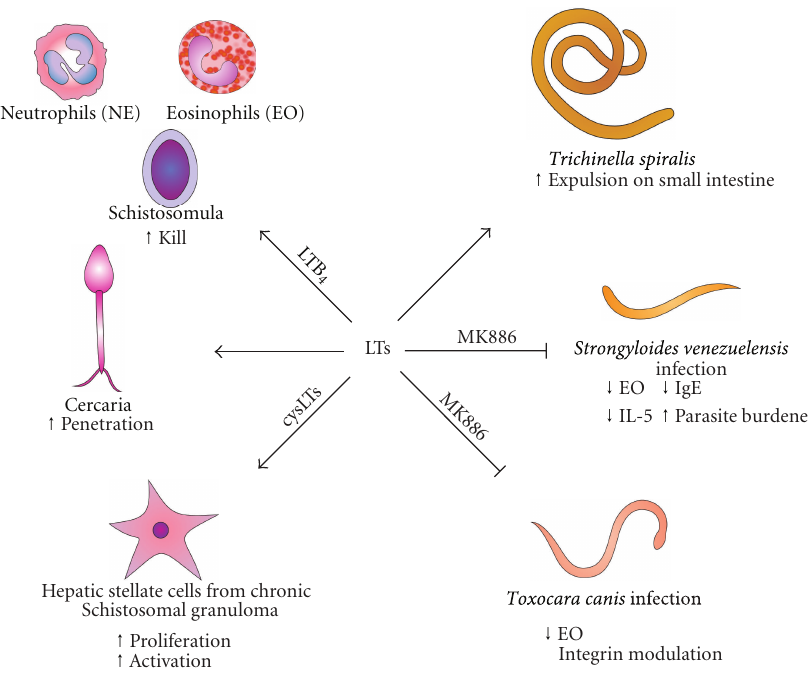
Figure 4: An overview of main e ff ects of LTs in helminth infections. LTs participate of expulsion of T. spiralis in the intestine. The inhibition of LTs resulted in increases of parasitemia and decreases IgE levels, eosinophil numbers and IL-5 concentrations in mice infected with S. venezuelensis . LT inhibition also reduced the eosinophil recruitment to tissues and on blood eosinophilia in experimental T. canis infection. LTB 4 enhanced the ability of neutrophils and eosinophils to kill the schistosomula of S. mansoni . LTs play important roles in the penetration of the skin by the schistosome cercariae. CysLTs are involved in the proliferation and activation of hepatic stellate cells from S. mansoni